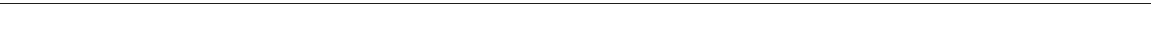
Fig. 1 hlx1 regulates hematopoietic stem cell formation and myeloid cell maturation in zebra fi sh. a – b Whole-mount in situ hybridization (WISH) for runx1 ( a ) and rag1 ( b ) in control or fl i: h HLX OE zebra fi sh embryos at 36 or 96 hpf, respectively. Arrows indicate HSPCs. Numbers in the bottom right corner of panels indicate the number of zebra fi sh embryos with the indicated phenotype compared to the total number of zebra fi sh analyzed. Quanti fi cation of WISH was performed using FIJI software and statistical signi fi cance of three independent experiments in 12 zebra fi sh embryos was evaluated by Student ’ s t -test, * P < 0.05, ** P < 0.01 (mean + s.d.). c WISH for the early myeloid marker pu.1 in control or fl i: h HLX OE zebra fi sh embryos at 48 hpf. Numbers and WISH quanti fi cation was performed as described above ( n = 3, in total 12 fi sh, Student ’ s t -test, * P < 0.05, mean + s.d.). d Zebra fi sh caudal hematopoietic tissue (CHT) smears stained with May – Grünwald – Giemsa stain in control or fl i :h HLX OE embryos at 48 hpf. On the right, cell number counts of the indicated cell populations from 10 fi sh ( n = 3, mean + s.d., Student ’ s t -test, * P < 0.05). e EDU assay at 48 hpf in control, hlx1 morphants ( hlx1MO ) or fl i :h HLX OE zebra fi sh cells ( n = 2). f Zebra fi sh CHT smears stained with May – Grünwald – Giemsa stain in control or Runx :h HLX OE embryos at 5 dpf. On the right, cell number counts of the indicated cell populations from 10 fi shes, in two independent experiments (mean + s.d., Student ’ s t -test, ** P < 0.01, **** P < 0.0001). g WISH for runx1 and rag1 in control or hlx1MO embryos at 36 and 96 hpf, respectively. h Representative images of Tg(Runx:mCherry) embryos at 72 hpf, injected or not with hlx1 morpholino and the indicated amounts of fl i: h HLX construct. Numbers of mCherry-positive HSPCs from each embryo are represented in